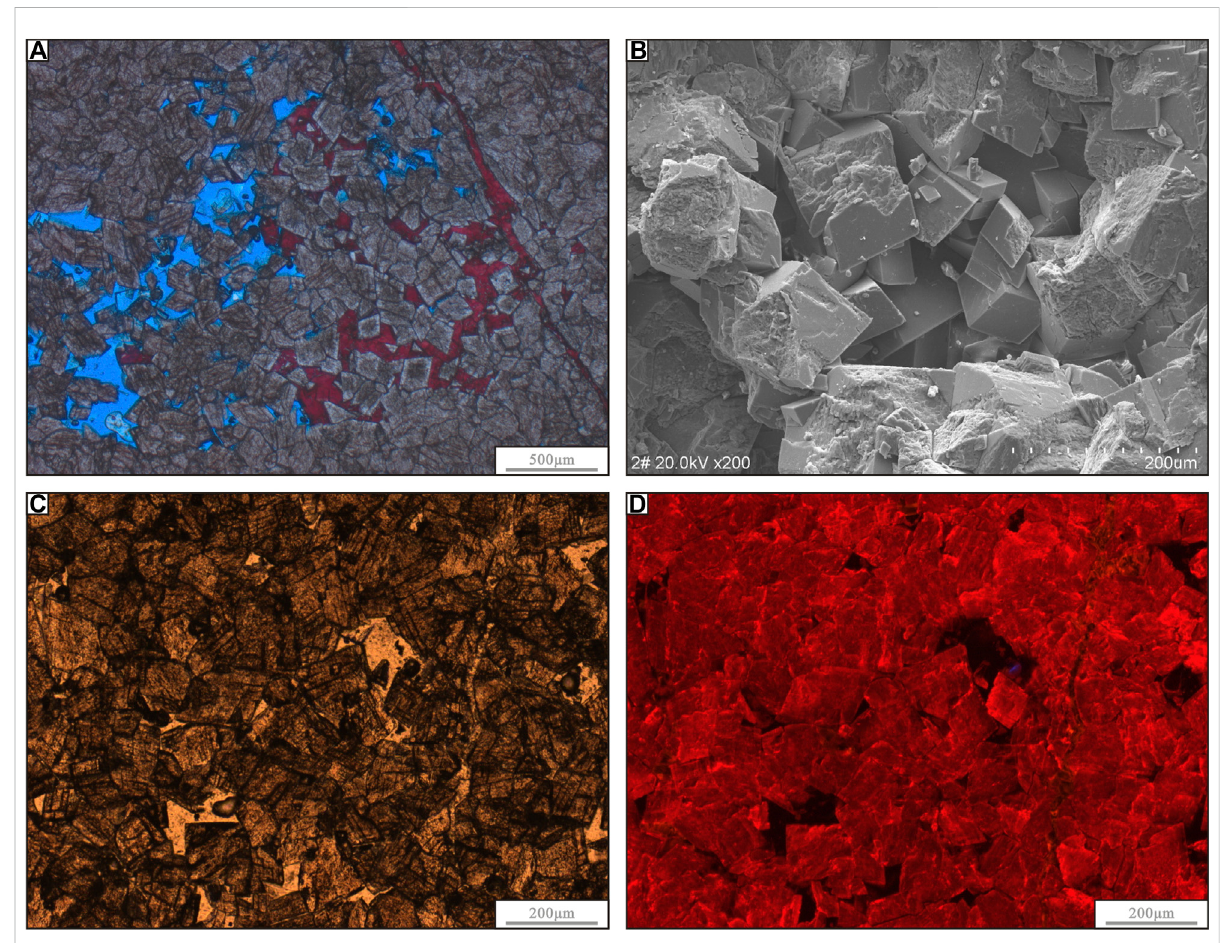
FIGURE 3 Petrological characteristics of Rd2. (A) . Plane-polarized-light image of an Rd2 sample with fi ne crystalline size and showing planar euhedral textures, some dolomites with misty center and clear rim, and some calcite- fi lled pores. The sample was obtained from well QK-1 in the Buqu Formation at a depth of 352.74 m. (B) . Scanning electron microscope image of an Rd2 sample showing planar euhedral textures, some mostly rhombohedral dolomite, and partially dissolved dolomite. The sample was obtained from well QZ11 in the Buqu Formation at a depth of 597.34 m. (C) . Plane-polarized-light image of an Rd2 sample with fi ne crystalline size showing planar euhedral textures, a few dolomite areas with misty center and clear rim, and un fi lled pores. The sample was obtained from well QZ11 in the Buqu Formation at a depth of 581.69 m. (D) . Cathodoluminescence image of the Rd2 sample in (C) . These crystals show a very dull-dull orange light that is brighter along the crystalline edge. In contrast, the pore shows no